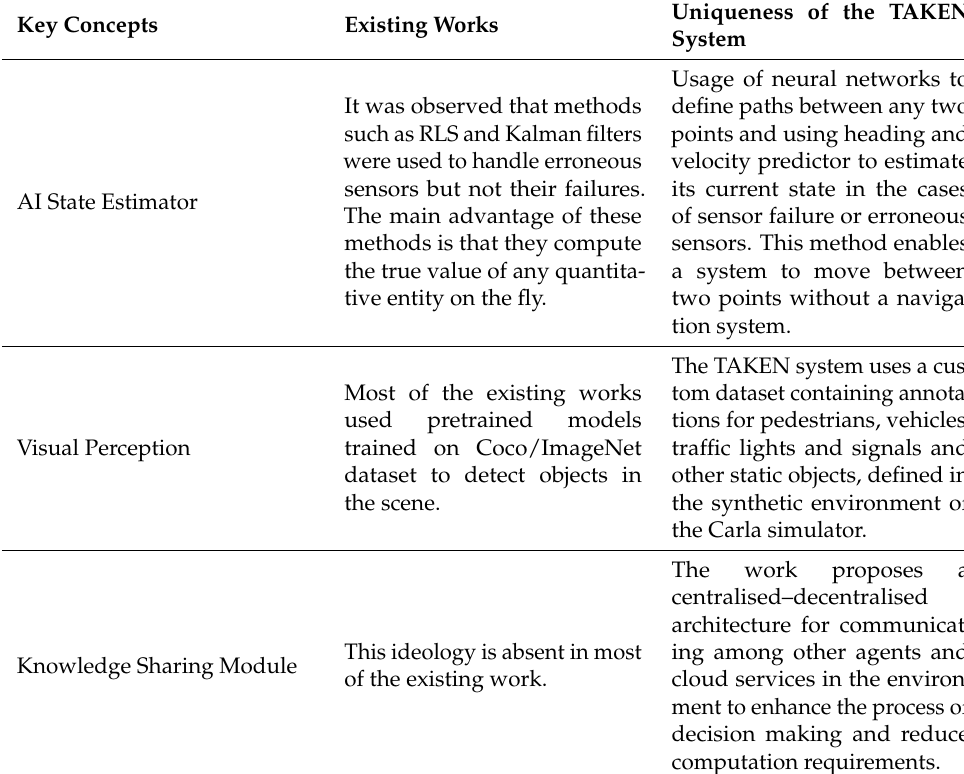
Table 1. Comparison of the TAKEN system with other existing